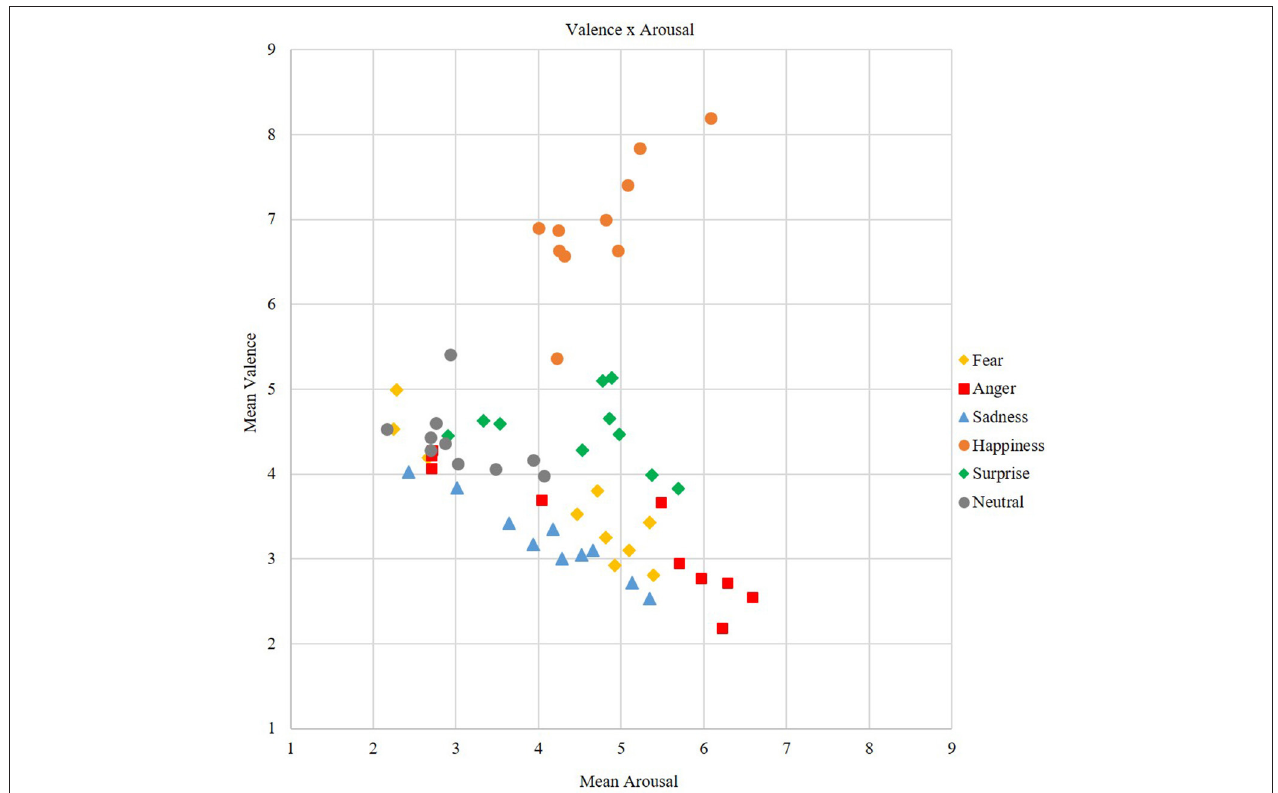
FIGURE 4 | Mean corresponding valence and arousal scores for each discrete